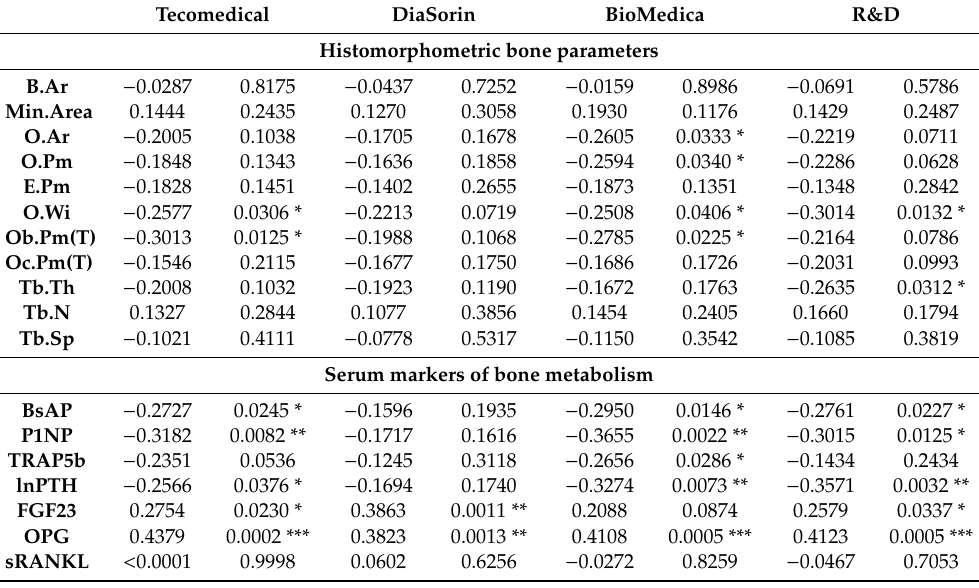
Table 6. Spearman correlation matrix of serum sclerostin concentration vs. histomorphometric bone parameters and serum markers of bone